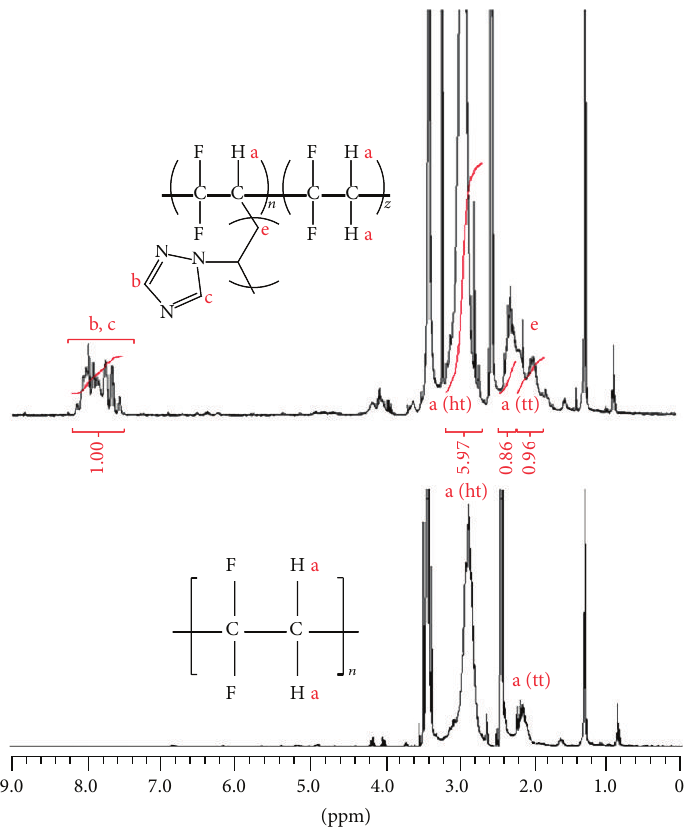
Figure 3: 1 H-NMR spectra of PVDF and PVDF- g -PVTri recorded in DMSO-d 6